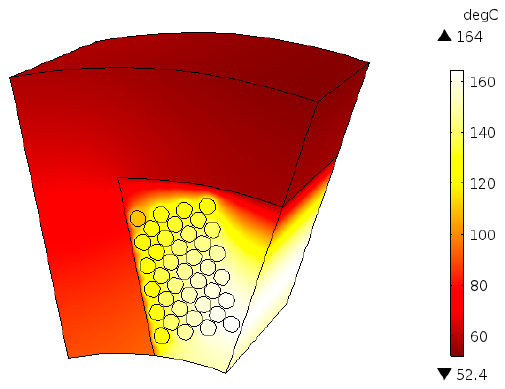
Figure 10. Non-uniformly distributed temperature obtained from the thermal analysis.